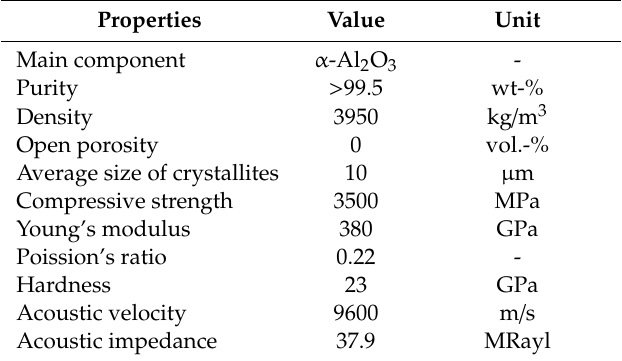
Table 4. Properties of the high-purity alumina used for matching